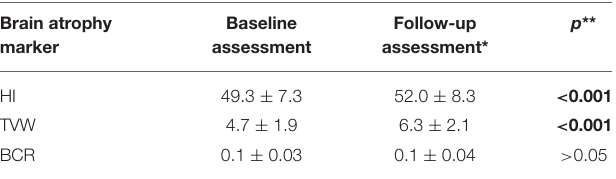
TABLE 4 | Brain atrophy markers at the baseline and follow-up assessments in patients with